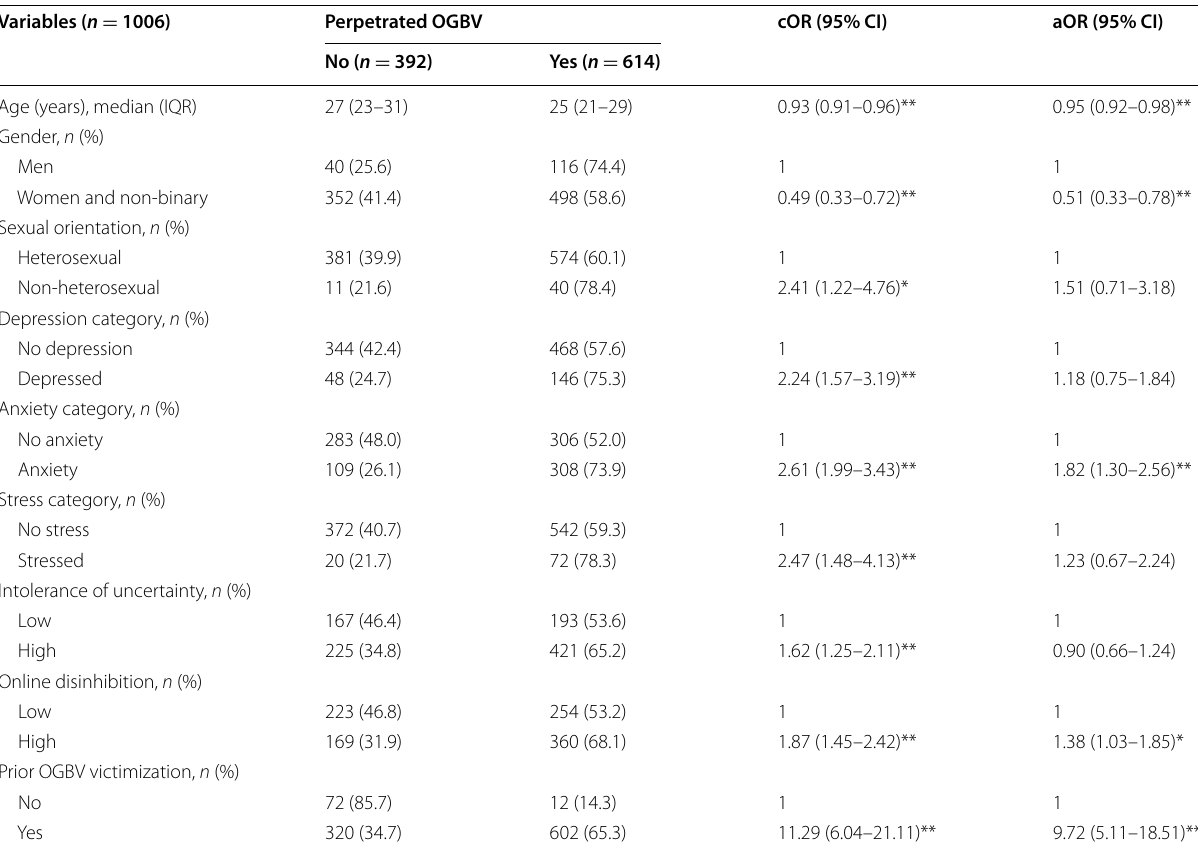
Table 3 Bivariate and multivariate analysis for determinants of perpetrating OGBV